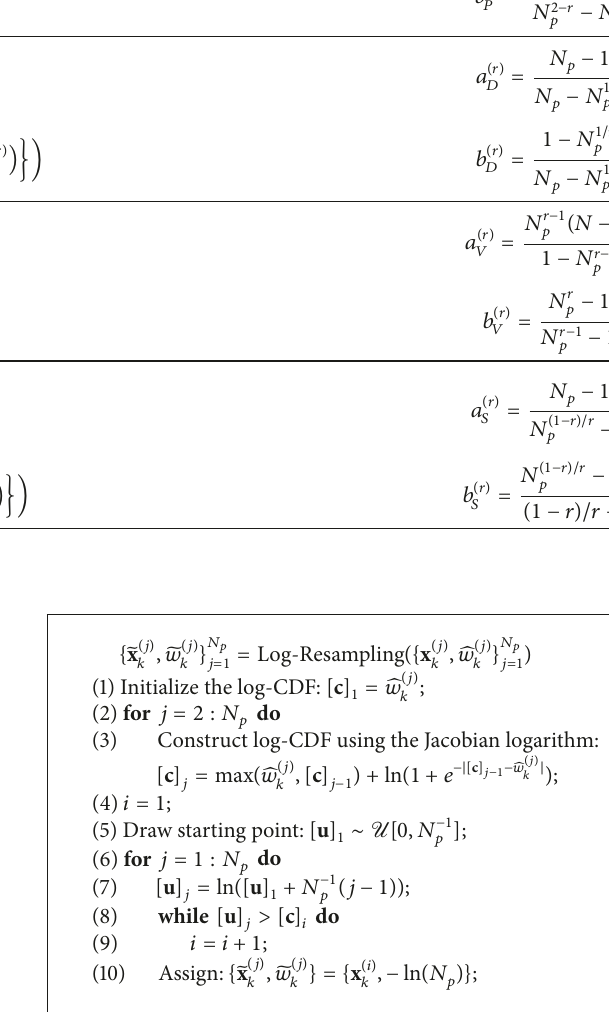
in lin-domain as defined in [14] eff ( w ) with 𝑟 = 2 . 𝑘 𝑁 𝑝